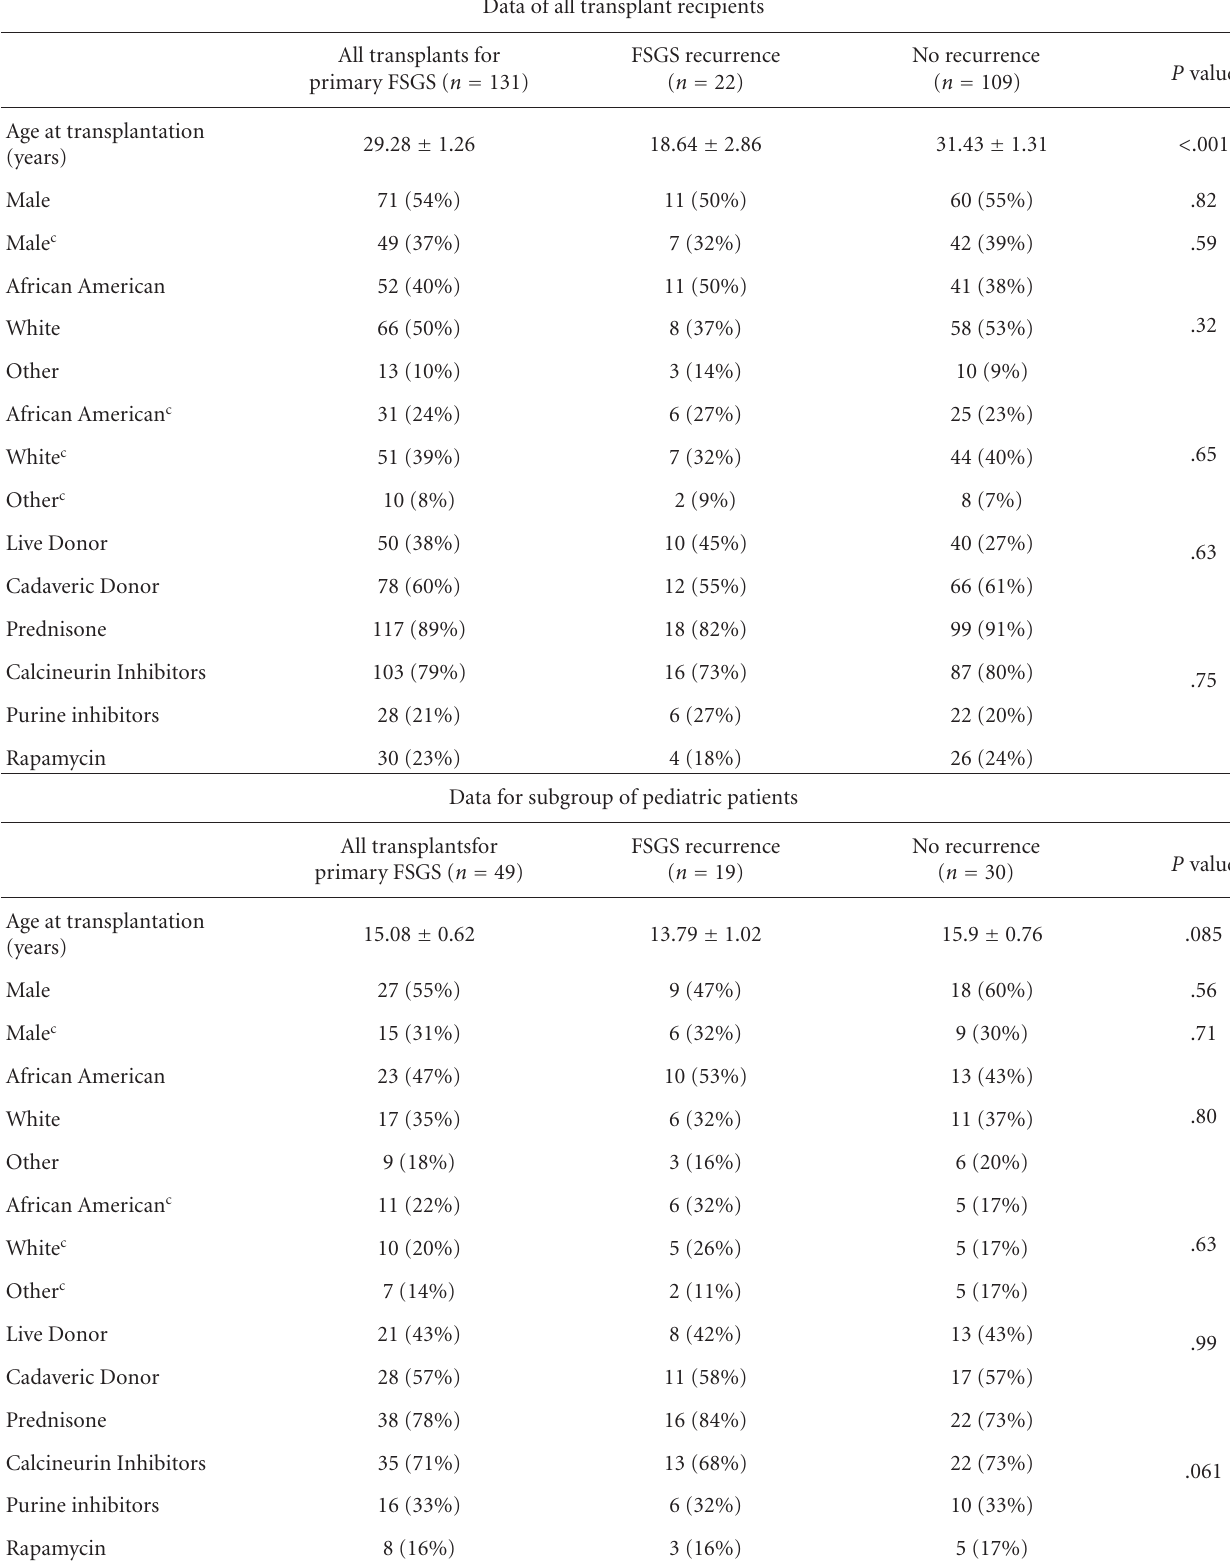
Table 2: Demographics of recurrent Focal Segmental Glomerulosclerosis in renal allograft recipients from 1990 to 2007 at Montefiore Medical